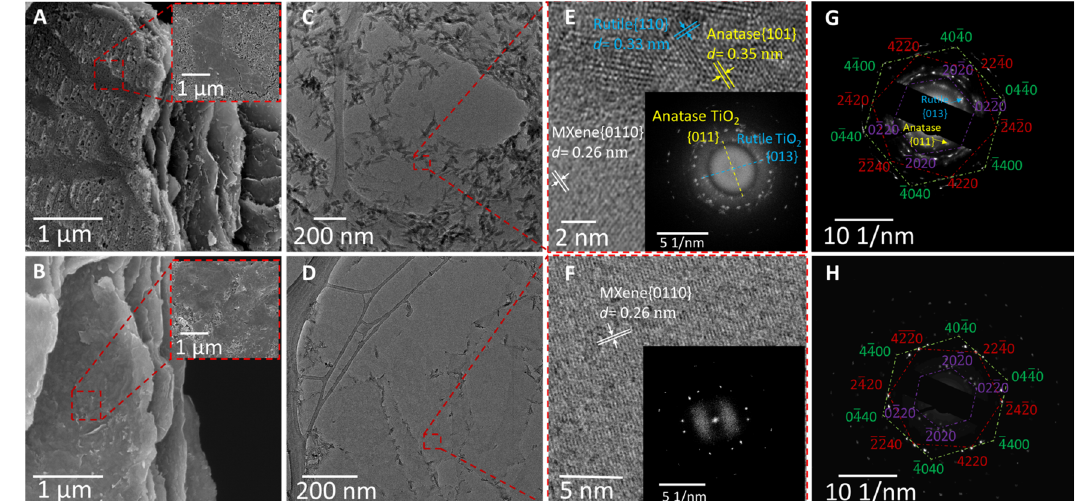
Fig. 2 | Electron microscopy. A , B Scanning electron microscopy (SEM), ( C , D ) transmission electron microscopy (TEM), ( E , F ) high resolution TEM (HRTEM) images, and, ( G , H ) corresponding selected area electron diffraction (SAED) pat- terns of the oxidized (control; top row: A , C , E , G ) and SRBW-recovered (bottom